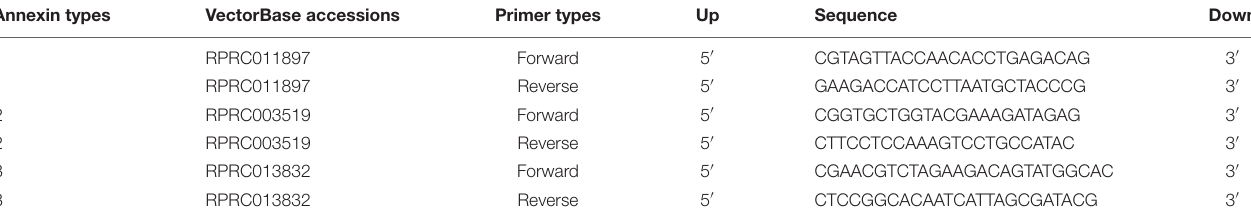
TABLE 1 | Primer sequences for annexin detection.